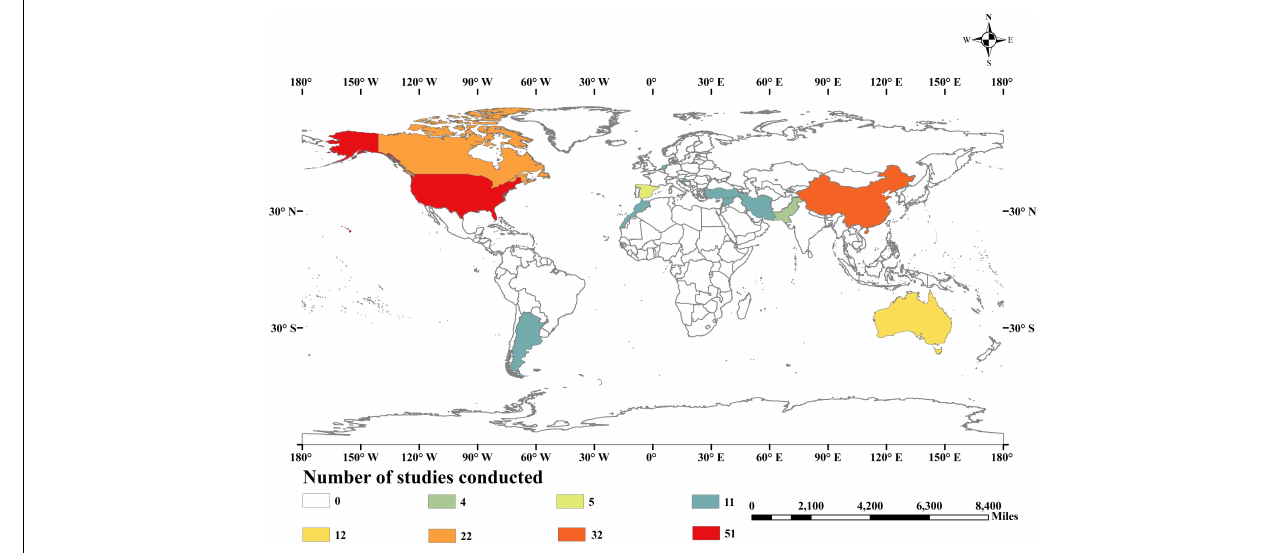
FIGURE 1 | Distribution of 137 experimental sites around the globe from where the data was collected for the meta-analysis.